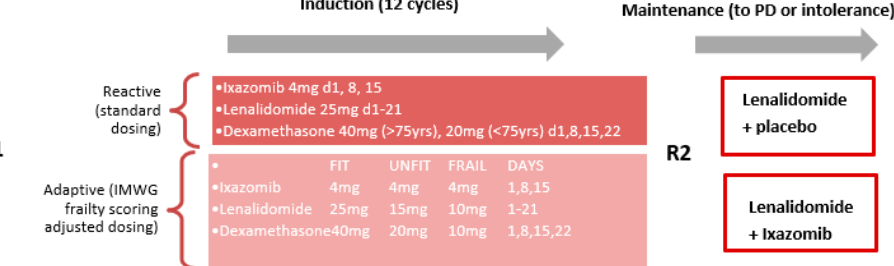
Figure 1. Adapted from The FiTNEss trial (Myeloma XIV) trial, which is a UK-MRA phase III, multi-centre, randomised controlled trial for transplant-ineligible, newly diagnosed MM patients. Patients are first randomised (R1) to standard (reactive) or frailty-adjusted (adaptive, based on IMWG score) with the triplet ixazomib, lenalidomide, and dexamethasone (IRd). A second randomisation (R2) compares progression-free survival with maintenance lenalidomide plus placebo (R) and lenalidomide plus ixazomib (IR). Adapted from Coulson BA et al. (2022) [18].